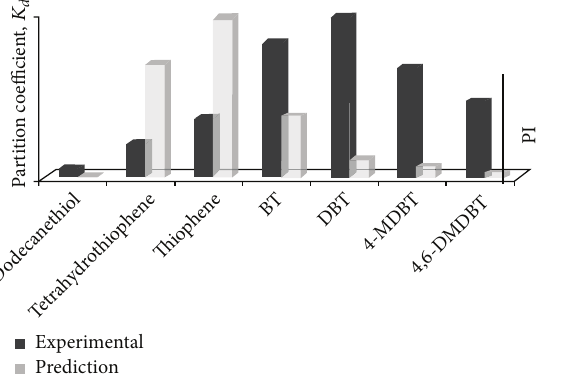
Figure 1: Comparison of extractability ( 𝐾 𝑑 value) of the sulfur species from 𝑛 -C 12 collected from the literature [8, 10] and COSMO- RS prediction.